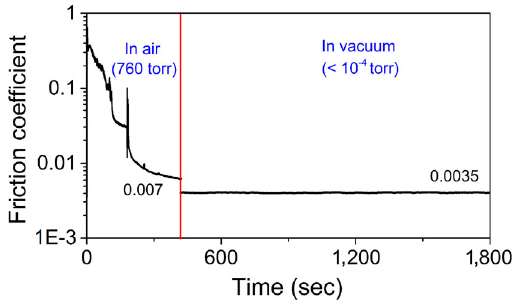
Fig. 2 Superlubricity state with H 3 PO 4 solution maintains in higher vacuum degree condition (<10 –4 torr) after the pre-running-in process in